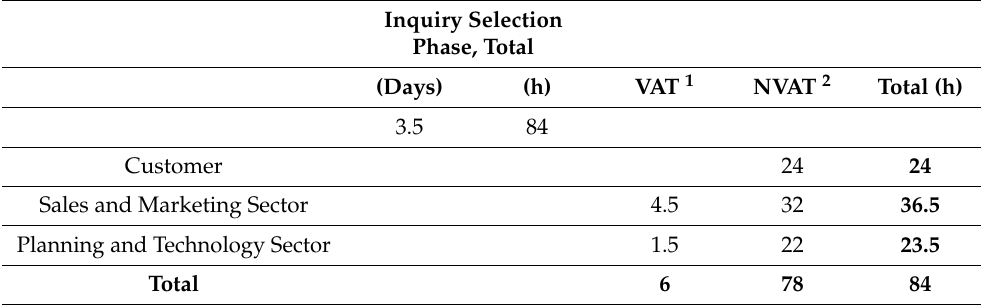
Table A2. The average durations of the inquiry selection phase activities—the current state.